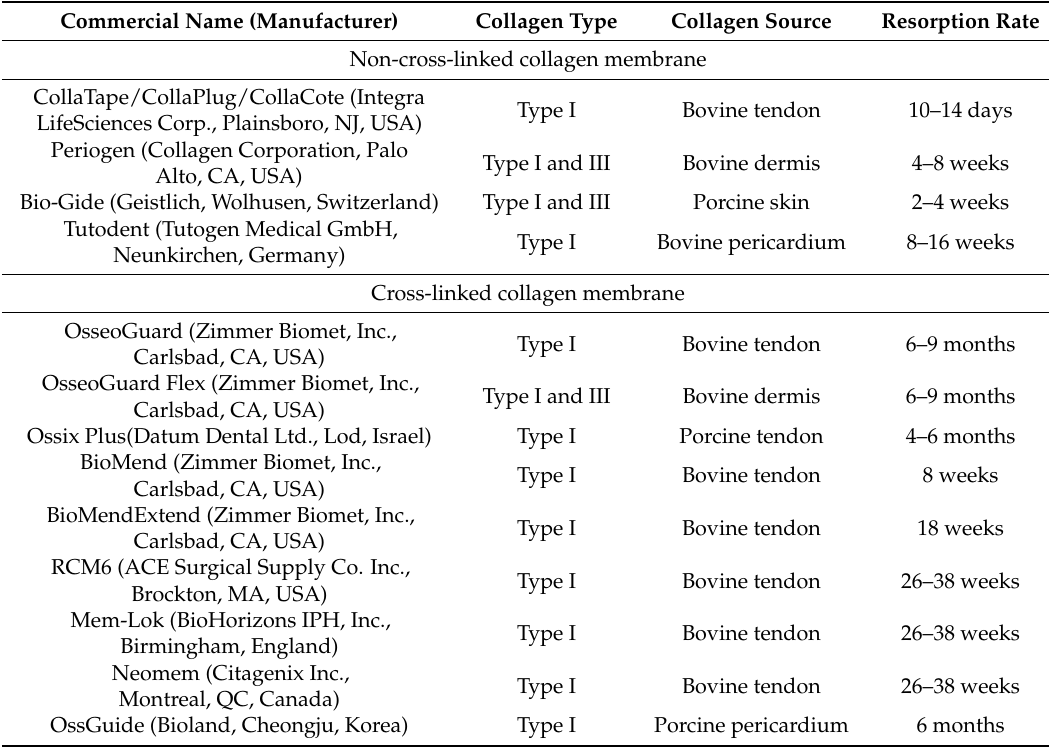
Table 2. The most commonly used commercially available resorbable collagen